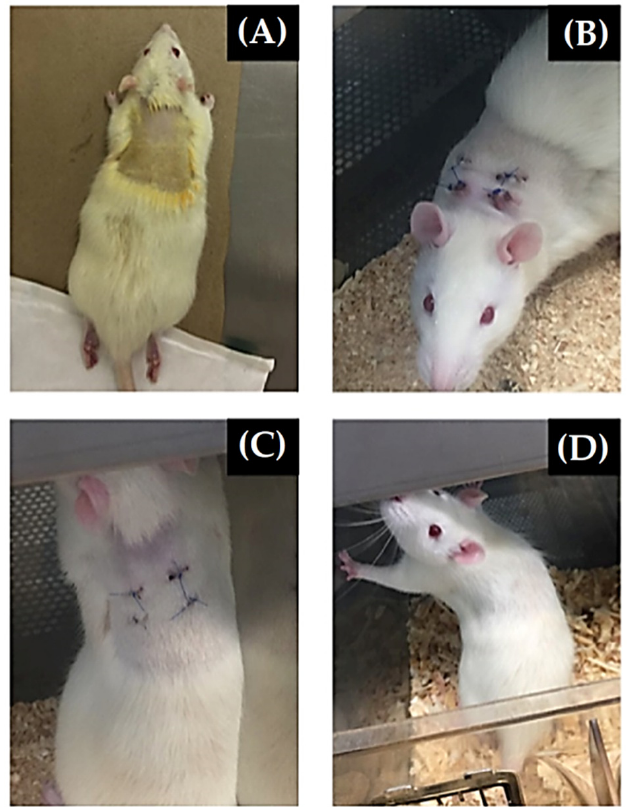
Figure 3. Evolution of the implant area in Wistar rats: ( A ) control rat prior to surgical intervention; ( B ) two weeks after material implantation, being observed inflammation in the incisions on the subcutaneous tissue; ( C ) four weeks of the surgical intervention, with a significant decrease in inflammation; and ( D ) six weeks after the intervention, the rat showed a very noticeable surgical decrease in the incisions’ inflammation, with a considerable growth in the rat’s hair and its scars (reprinted from Garibay-Alvarado et al. [74], copyright (2021), with permission from PloS